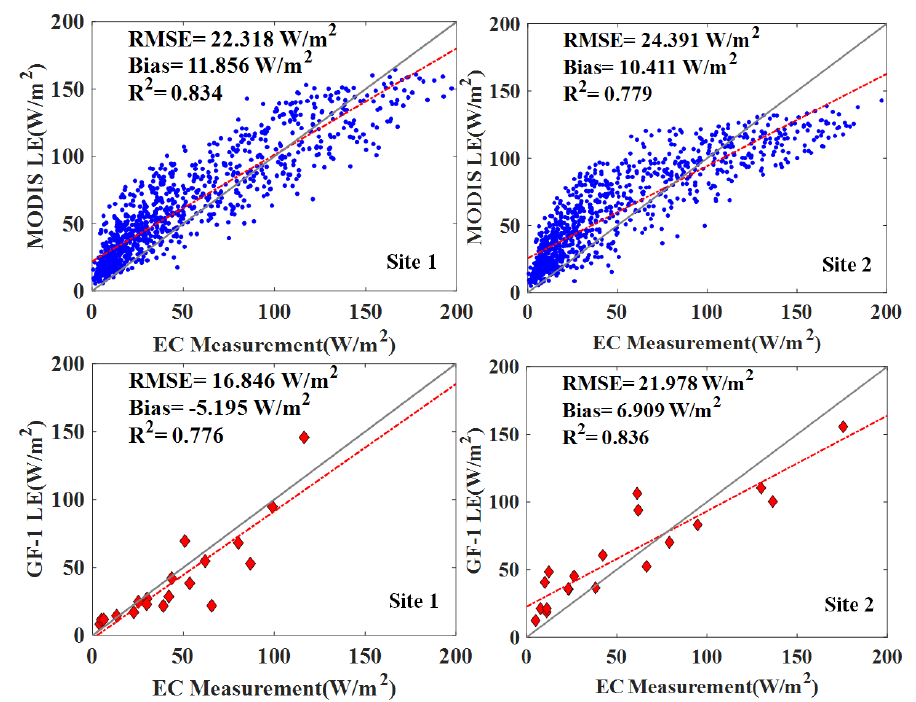
Figure 3. Scatterplots of the satellite derived LE products and ground measurements at daily scale during 2014–2017. The blue circle and red diamond represent the MODIS and GF-1-derived LE products, respectively.